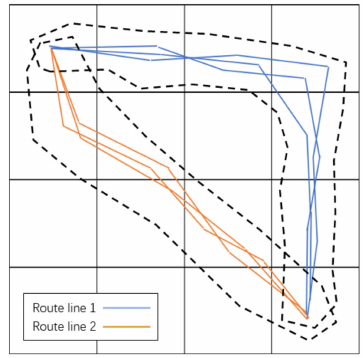
Figure 5. Dot connection diagram